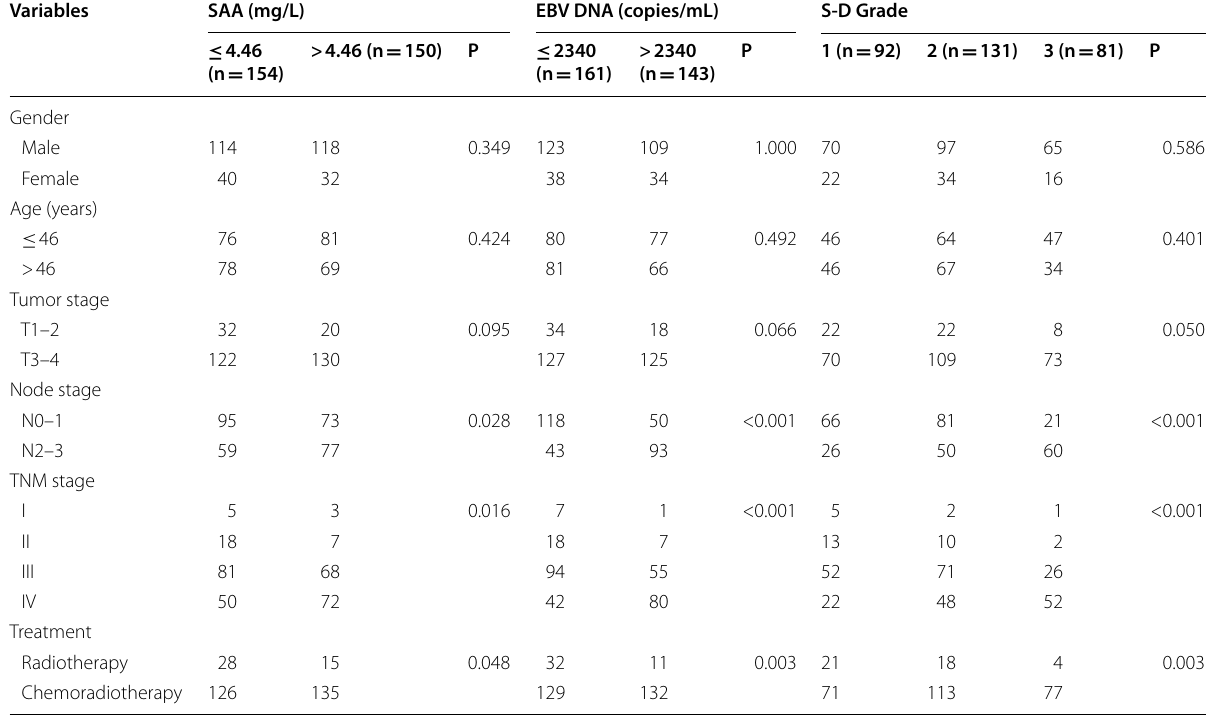
Table 5 Relationship between the SAA and EBV DNA pretreatment and the clinical characteristics in 304 patients with